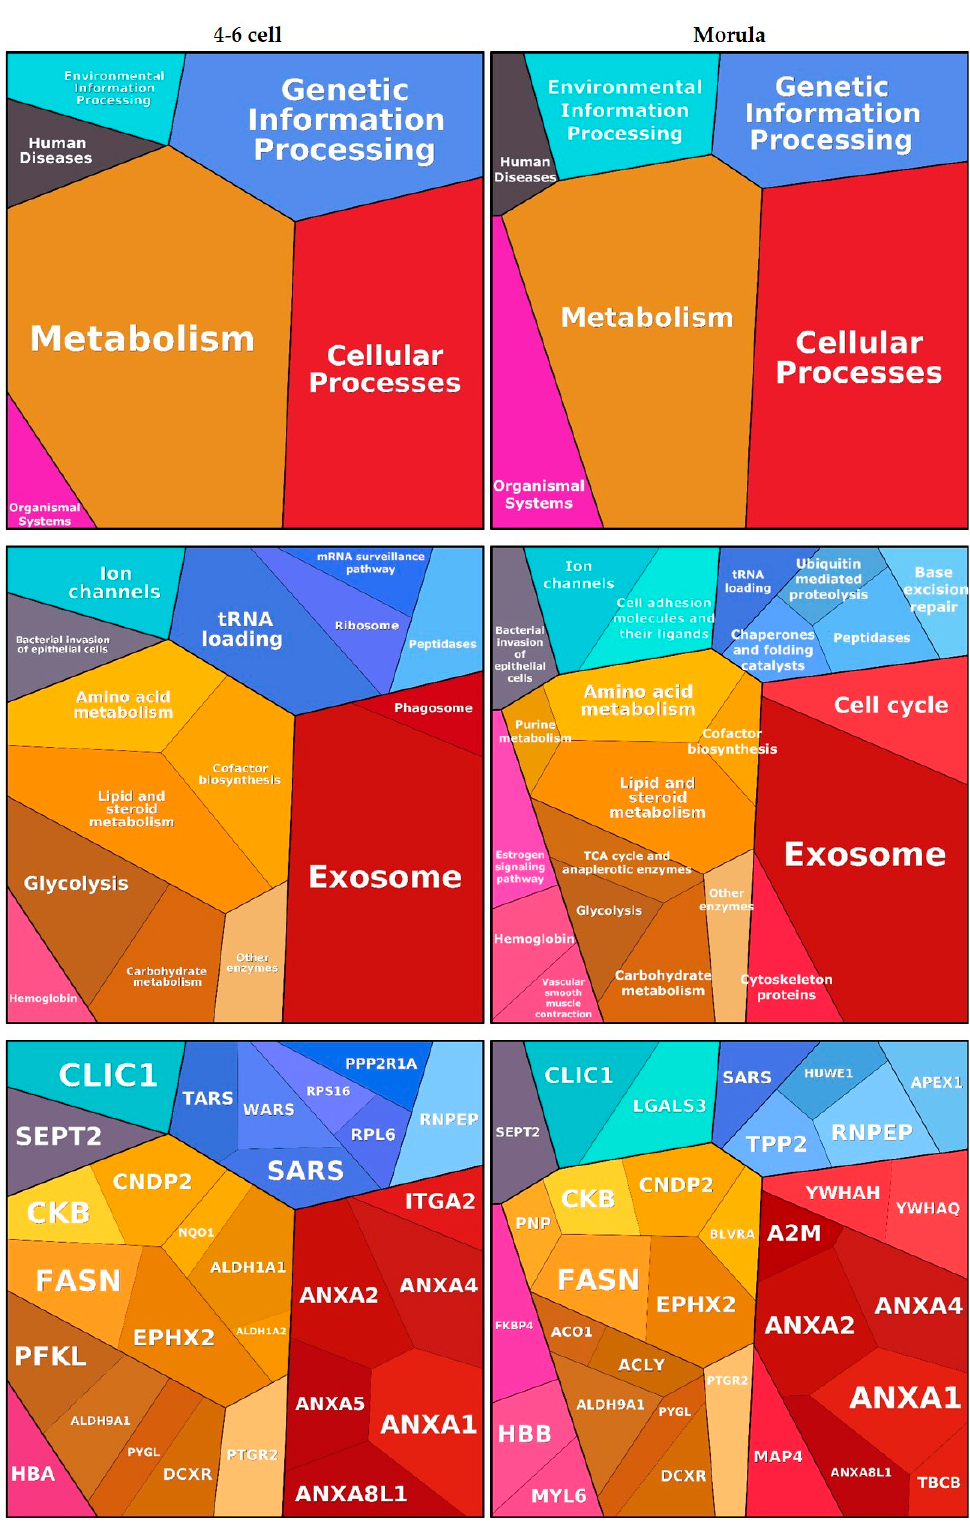
Figure 3. Functions associated with embryo-interacting proteins at the 4–6 cell and morula stages. The figures were automatically built in Proteomaps based on the KEGG (Kyoto Encyclopedia of Genes and Genomes) Pathway gene classification. Functional categories (up and middle panels) and related proteins (down panel) are shown by polygons. Areas of polygons illustrate protein abundance, weighted by protein size. Functionally related function / protein are arranged in common regions and coded using similar